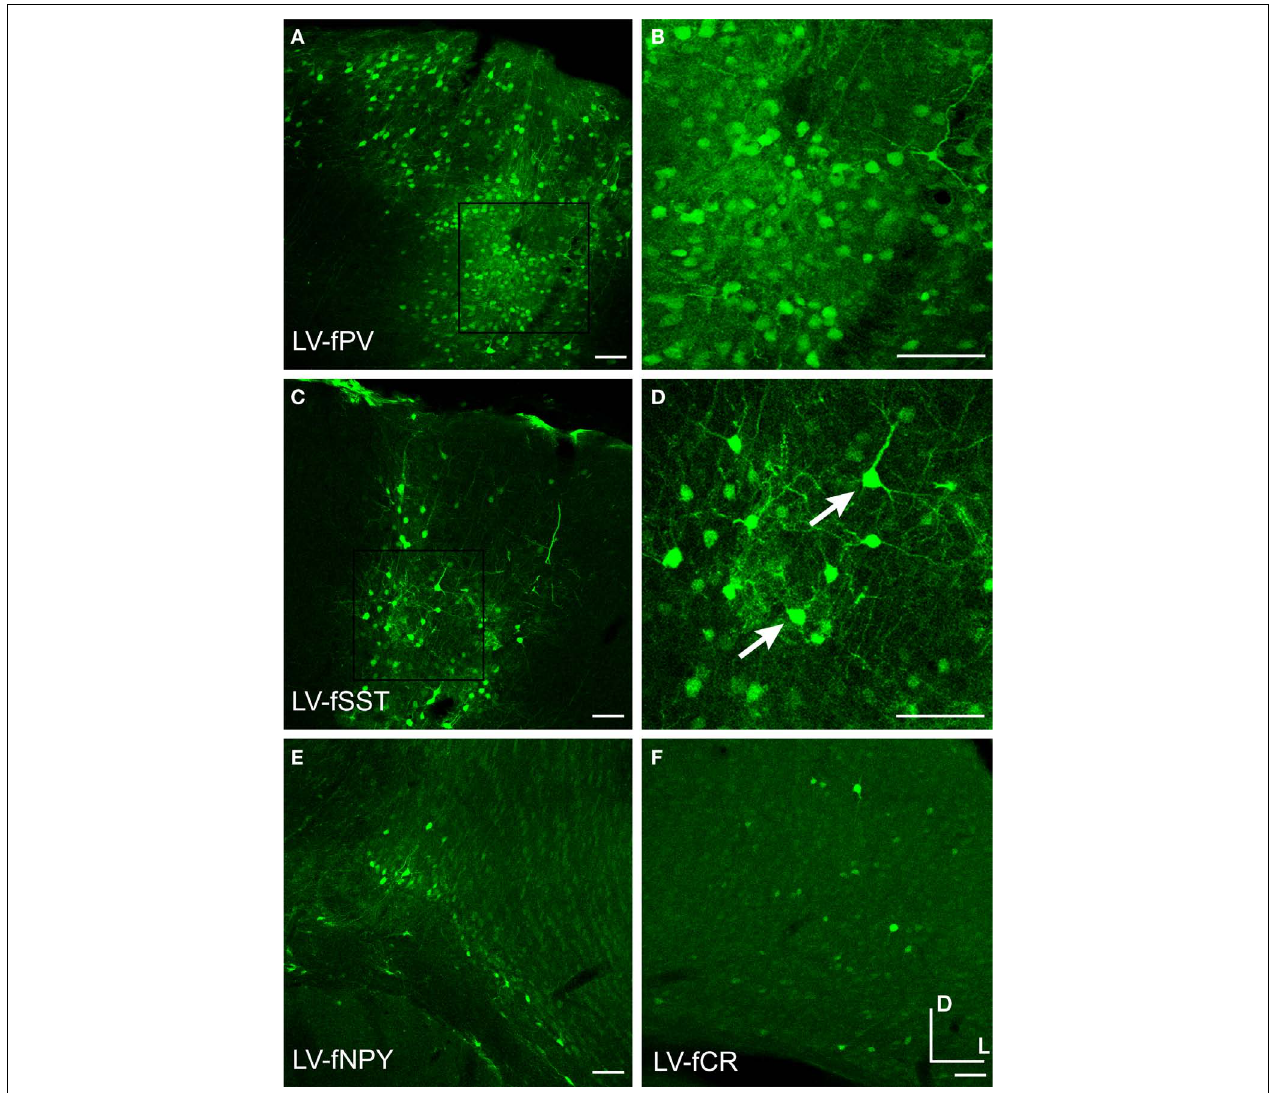
FIGURE 9 | Fugu promoters in LV drove expression in large numbers of excitatory neurons. Fugu promoters in LV expressing GFP were injected into mouse somatosensory cortex – LV-fPV (A,B) , LV-fSST (C,D) , LV-fNPY (E) , LV-fCR